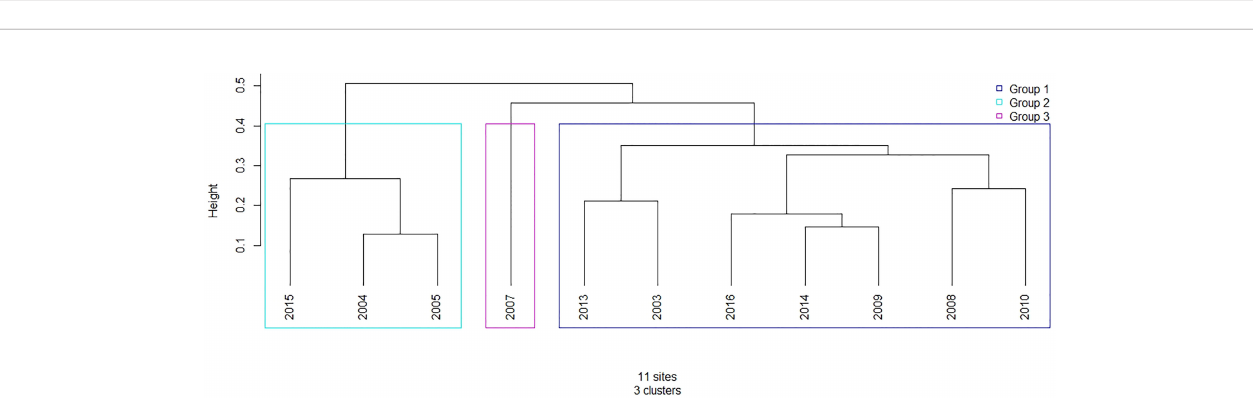
FIGURE 9 | Cluster dendrogram for the Central Strait of Georgia crustacean community abundance from 2003-2016 using the Unweighted Pair-Group Method using the arithmetic Averages (UPGMA) method for hierarchical clustering. Years with fewer than 3 months of data (2006, 2011, 2012) were excluded from analysis.